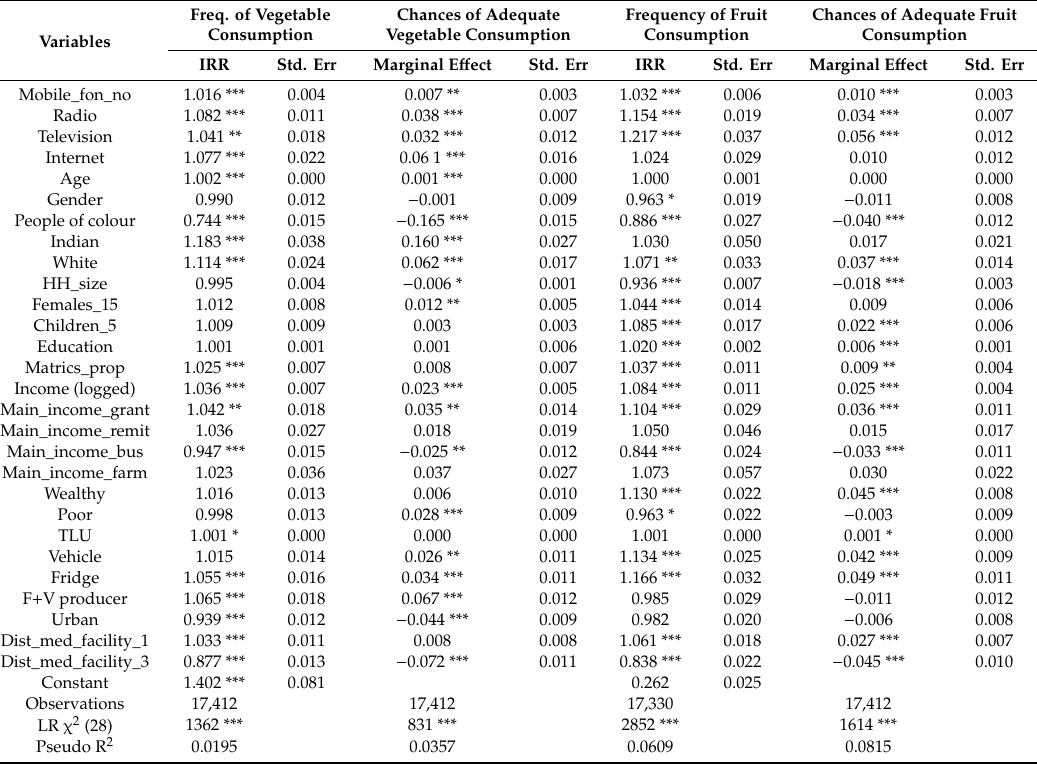
Table 4. Determinants of vegetables